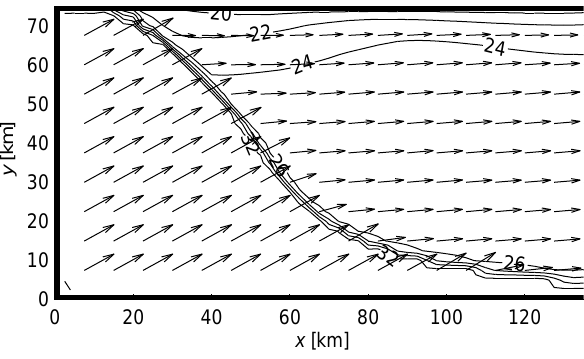
Fig. 6. Ice velocity ( v ) and speed ( | v | ) in the control experiment after eight days of model integration. The polynya edge is visible as a sharp decrease in the ice velocity.